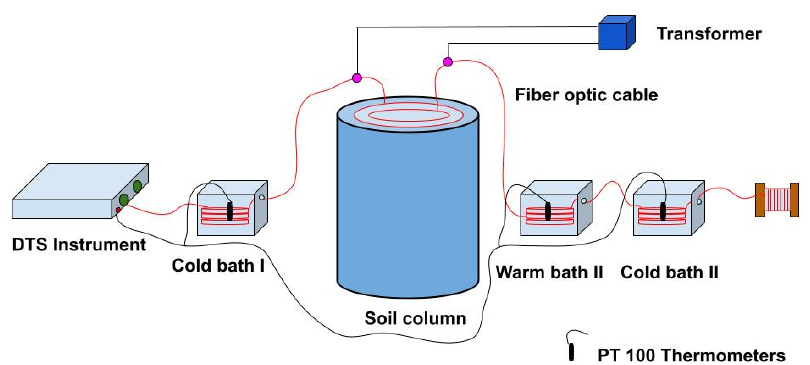
Figure 3 . Diagrammatic view of the experimental set up. It shows the single-ended cable configuration with three temper- ature calibration baths with PT 100 thermometers, DTS instrument, soil column, and other components. Electrical connec- tions were made to the fiber optic cable to send pulse, and the purple circles show the connection locations. The locations of electrical connections on the fiber optic cable were just before entering the cable and after the coming out of the cable from the soil